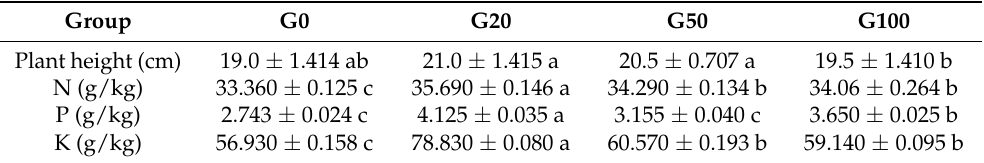
Table 4. Effect of different concentrations of graphene added to the soil on growth and nutrient uptake of pepper plants after 60 days grown from seeds. Group